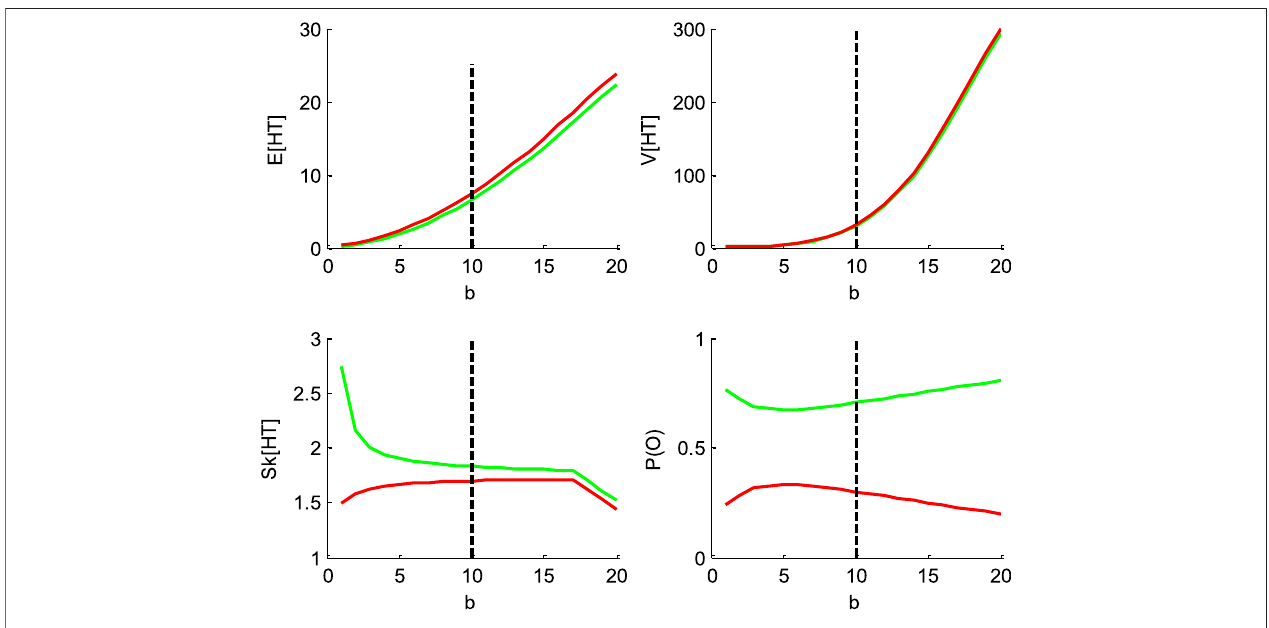
FIGURE 4 | Impact of the threshold ’ s height b . Same format as Figure 1